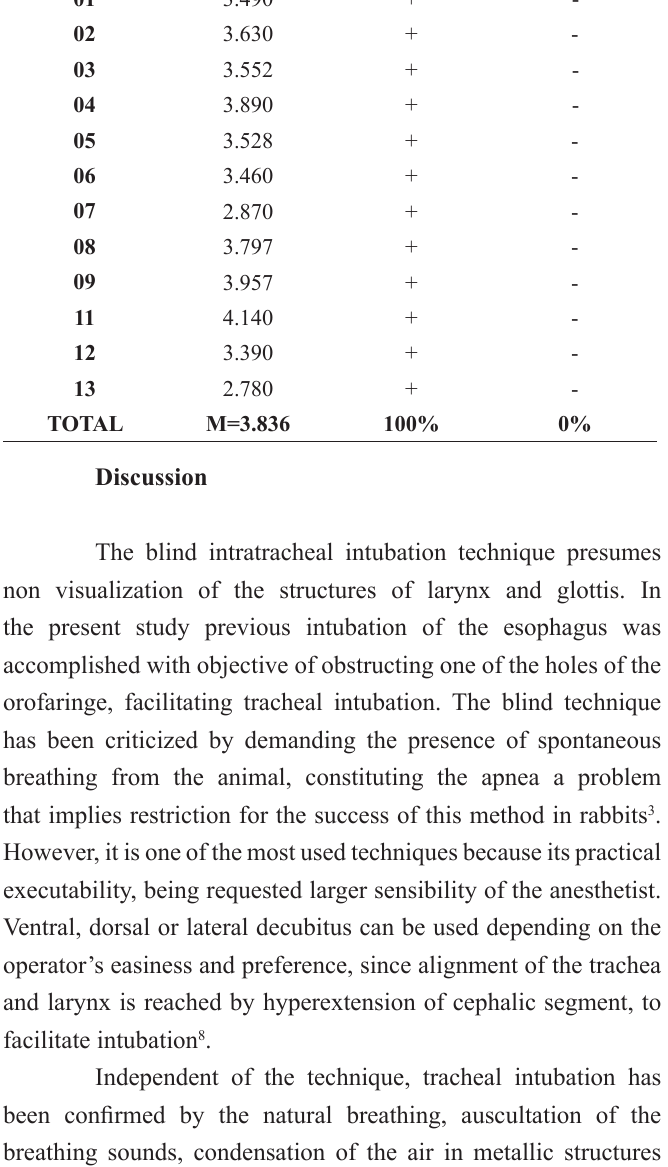
FIGuRE 1 - A and B . Previous canulization of the esophagus, being observed the immobilization of the gauze filament. C and d . Tracheal intubations, being observed displacement of gauze filament, corresponding to the expiratory flow as compared with gauze filament immobilization at the esophagus cannula. A and C. Note that the connector of the tracheal probe is at the level of superior incisive teeth of the animal. E . Condensation inside surface of the probe (black